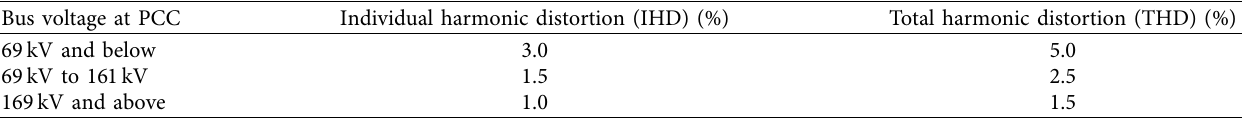
Table 1: Te harmonic voltage limits for power producer. Bus voltage at